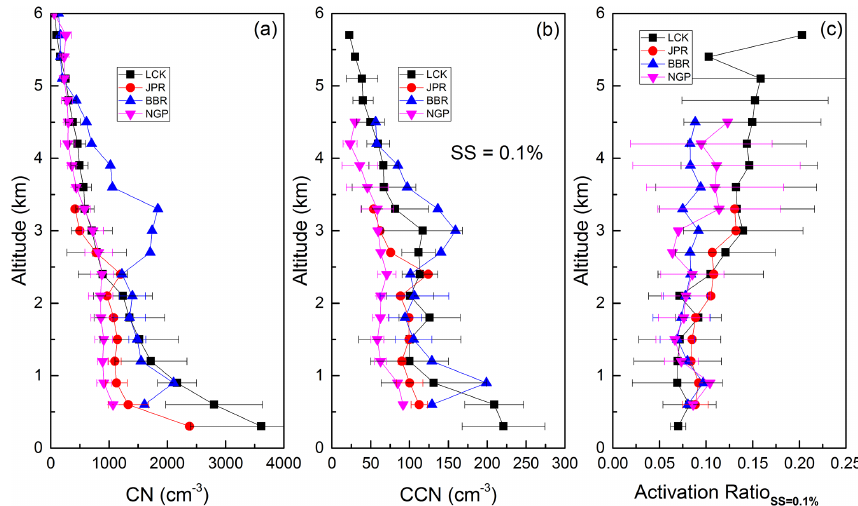
Figure 4. Comparison of CN, CCN and AR values at the different locations during Phase 1 of the campaign. The CCN and AR corresponding to 0.1% supersaturation are shown.